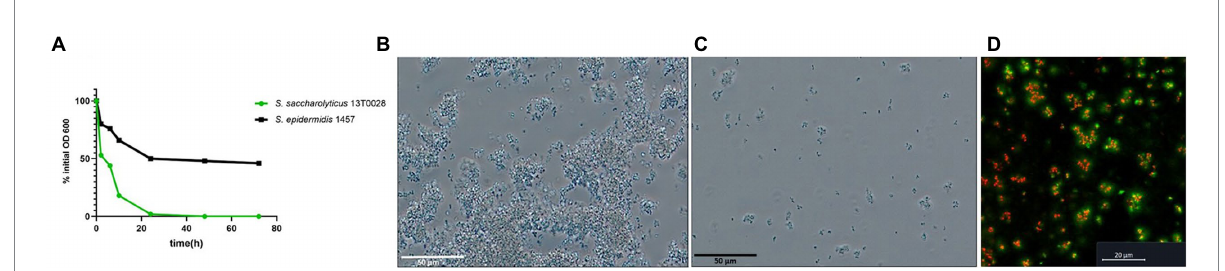
FIGURE 4 Autoaggreation of S. saccharolyticus . Autoaggregation of S. saccharolyticus 13 T0028 and S. epidermidis 1457 assessed by a sedimentation assay. Turbidity reduction is determined as a percentage of the initial OD 600 value (A) . Microscopical analysis of autoaggregation in S. saccharolyticus 13 T0028 (B) and S. epidermidis 1457 (C) , respectively, grown to an OD 600 of 0.5. Bacterial aggregates of viable cells (red) and dead cells (yellow) of S. saccharolyticus 13 T0028 and eDNA (green) visualized by CLSM (D)